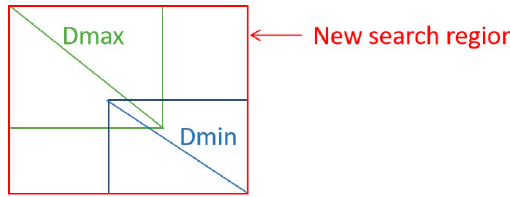
Figure 10. A description of the search region.